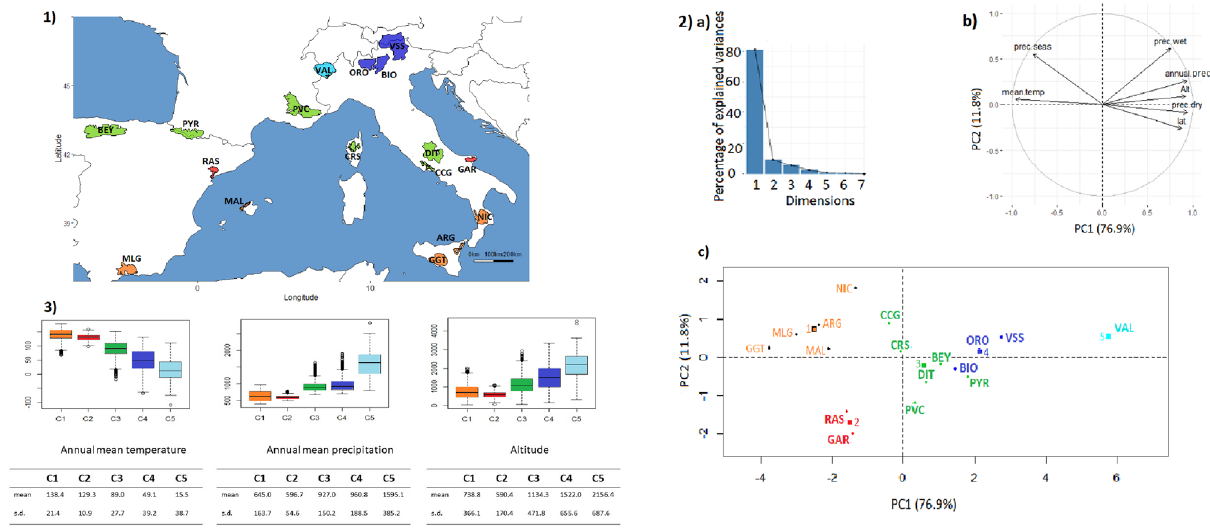
Figure 4. Goat cradles analyses as a function of environmental variables. ( 1 ) Mapping display of the cradles coloured according to the result of the clustering. ( 2 ) HCPC analysis. (a) Scree plot. (b) PCA correlation circle. (c) PCA score plot of goat cradles. Colours represent the main clusters obtained by HCPC (K = 5). PC 1 and PC 2 represent respectively principal components 1 and 2; numbers in brackets show the variance explained by each PC. ( 3 ) Boxplot representation for the variables Mean Annual Temperature, Mean Annual Precipitation and Altitude for the different HCPC groups and associated numerical values. Alt.: Altitude in meters, T°: Temperature in °C × 10, prec.: precipitation in millimeters, min.: minimal, max.: maximal, s.d.: standard deviation.